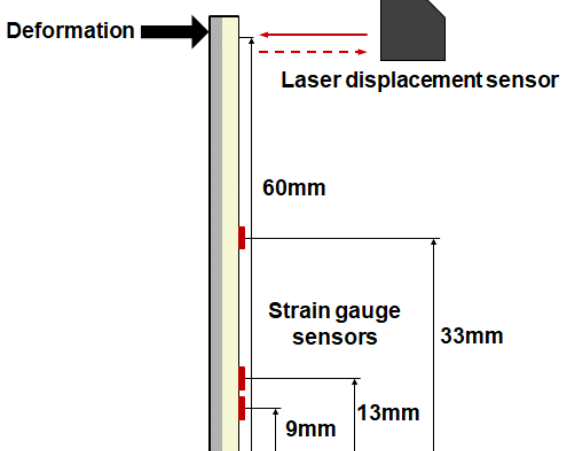
Figure 8. Measurement points of the multilayer beam.